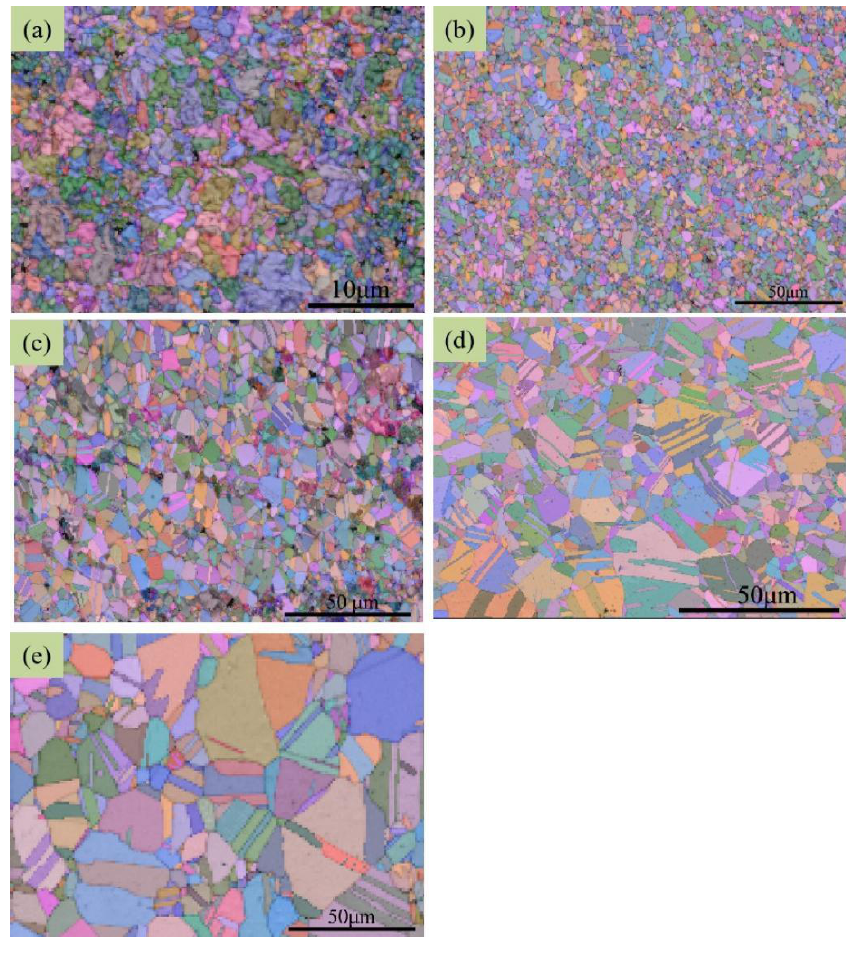
Figure 3. Euler maps of cold-rolled and annealed Cu-2.7Be sheets: ( a ) Cold rolled, ( b ) 650 ◦ C / 15 min, ( c ) 650 ◦ C / 60 min, ( d ) 770 ◦ C / 15 min, ( e ) 770 ◦ C / 60 min.